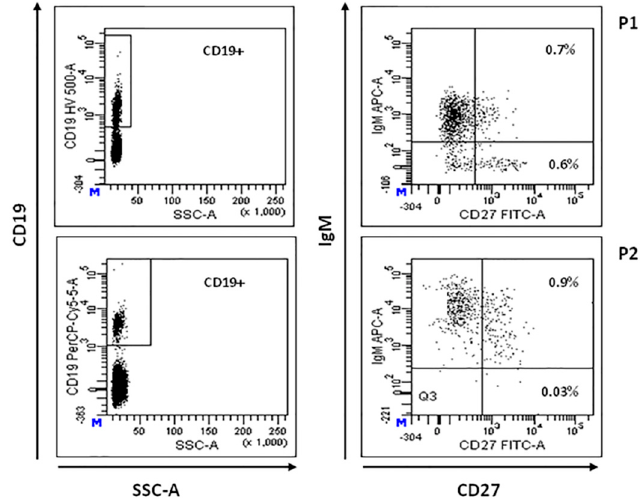
Figure 2. B-cell immunophenotyping. Representative flow cytometric plot showing total CD19 + cells (left panels), memory (CD19 + CD27 + IgM + ) and switched memory (CD19 + CD27 + IgM-) B-cell populations in patients P1 and P2 (right panels), expressed as percentage of total lymphocyte. CD40L and CD40 expression was normal in all cases except for P3, in whom CD40L expression was reduced. In particular P3 CD4 + T cells were not able to upregulate CD40L expression after stimulation, di ff erently from what was observed in cells from a healthy control (0.2% vs. 2.7%) (Figure 3). CD40LG gene alterations were ruled out by direct sequencing in this patient.